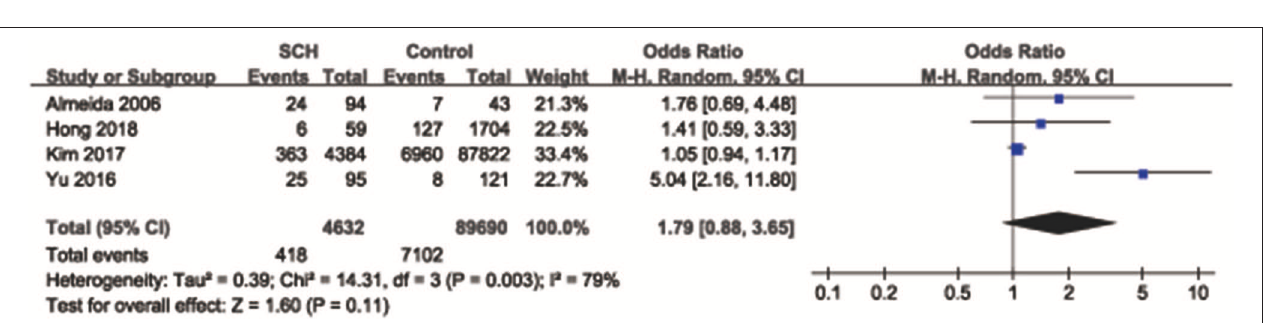
in participants with a mean age < 50 years (OR = 1.79, 95%